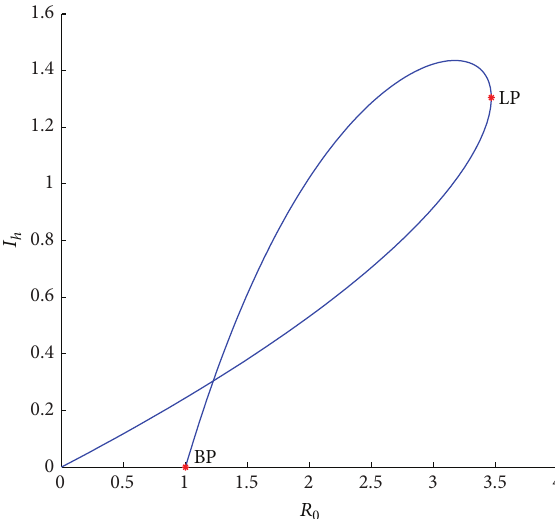
Figure 1: Bifurcation curves in (𝑅 0 , 𝐼 ℎ ) plane when 𝑟 = 0.8 , 𝐾 = 10 , = 1 , 𝑎 = 1 , 𝑎 = 0 , 𝑑 = 0.036 , 𝛾 = 0.06 , 𝛼 𝛽 1 1 2 ℎ ℎ = 0.06 , 𝛽 = 0.26 , and 𝑁 = 2 . 𝑑 V 2 V